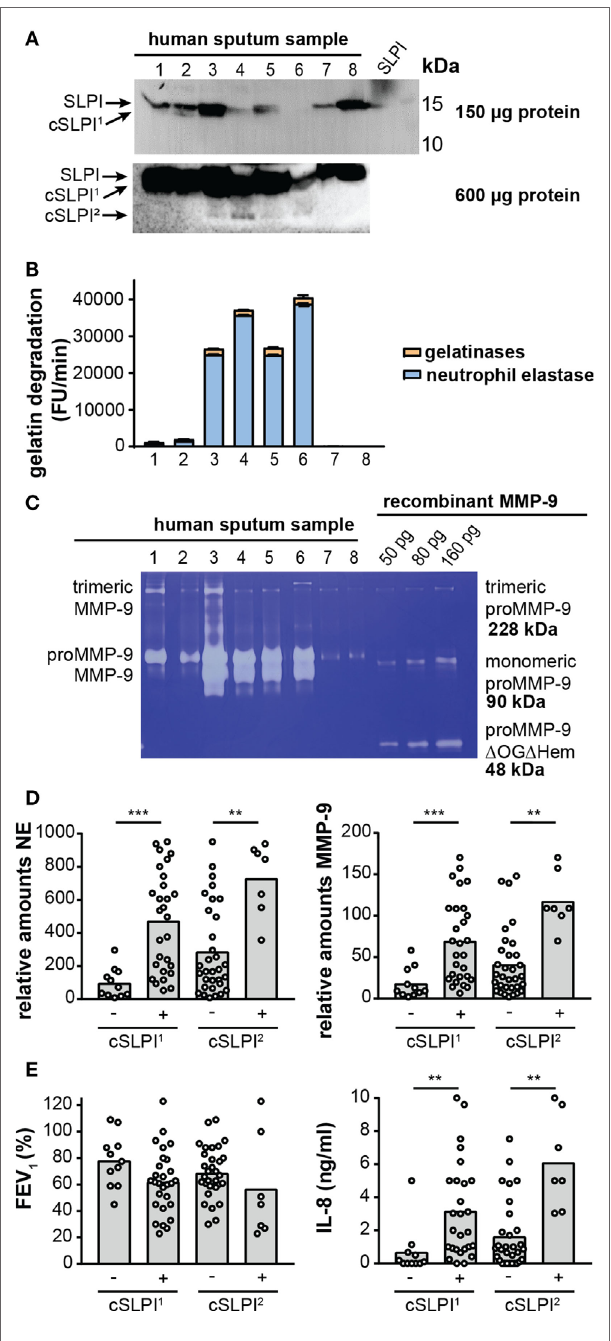
FigUre 4 | Lipopolysaccharide (LPS)-binding and anti-inflammatory properties of cleaved-SLPI. (a) , Analysis of LPS-binding capacity of secretory leukocyte peptidase inhibitor (SLPI) (blue), 1/20 cleaved-SLPI [matrix metalloproteinase-9 (MMP-9/SLPI)] (orange), and 1/5 cleaved-SLPI (MMP-9/ SLPI) (red) by LPS-binding ELISA. n = 3, statistical comparison of best fits by extra sum-of-square F test indicated that the SLPI curve is